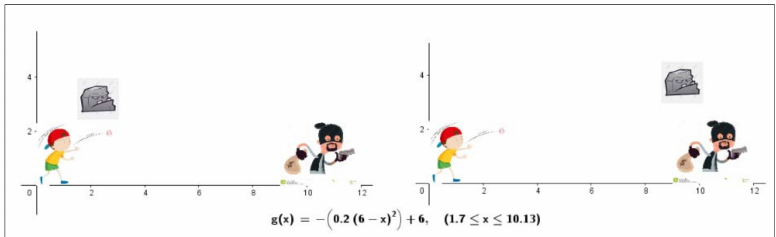
Figure 3. Participant 25; Mathematics task assignment, item